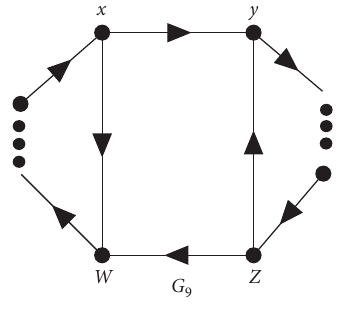
Figure 2: Singular